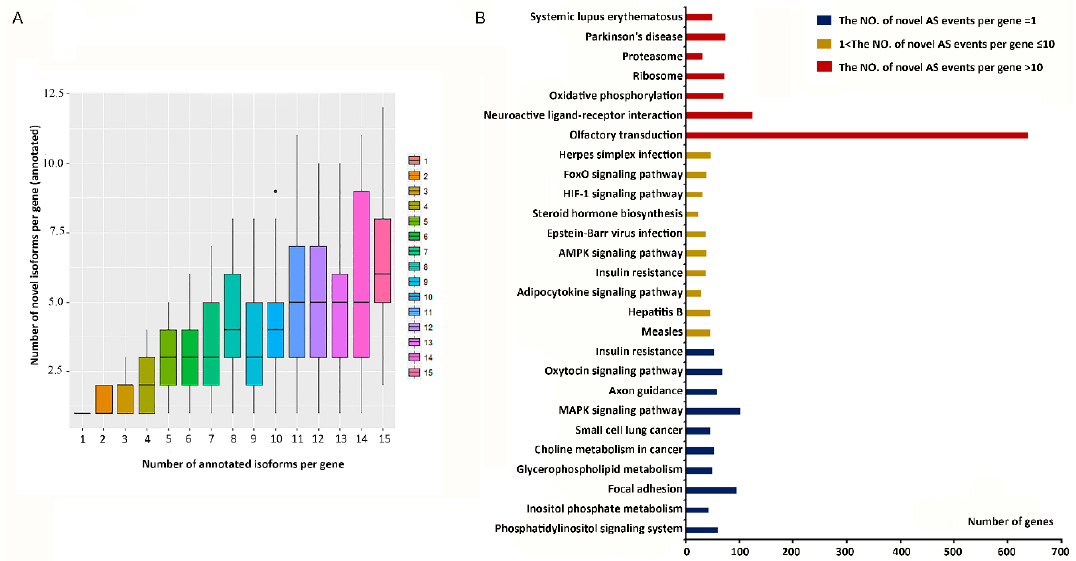
Figure 2. The difference in the number of alternative splicing-related genes. ( A ) The relationship between the number of annotated isoforms and novel isoforms per gene. ( B ) Top 10 enriched Kyoto Encyclopedia of Genes and Genome (KEGG) pathways of genes with different numbers of AS events (ASEs). Blue bars represent genes with one ASE, yellow bars represent genes with 1 < ASEs ≤ 10, and red bars represent genes with >10 ASEs.